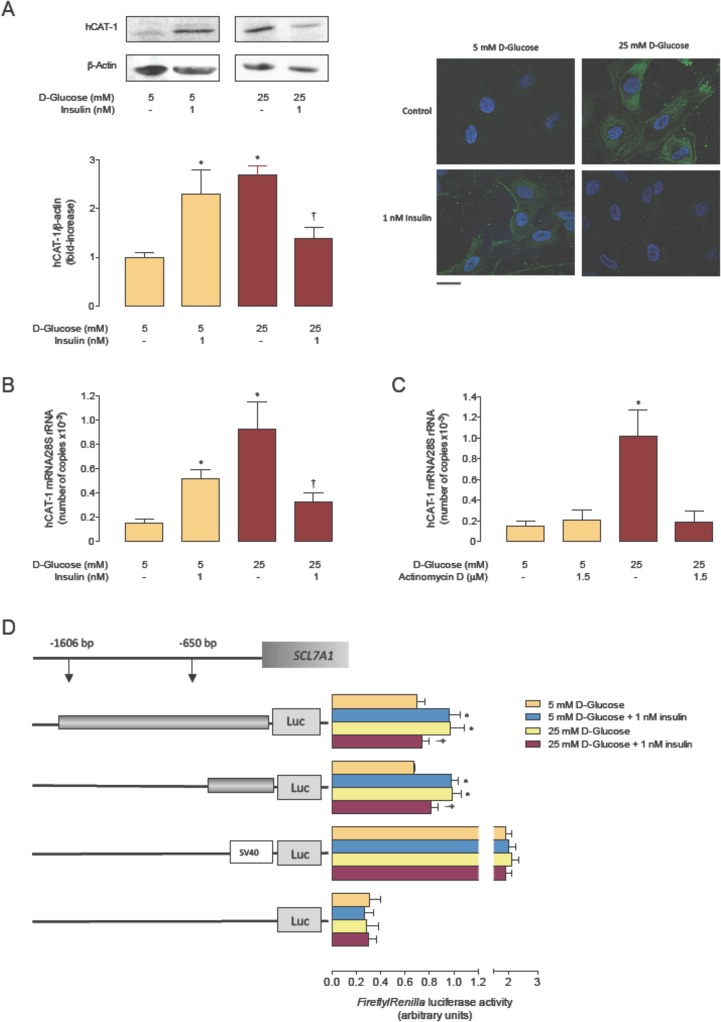
Insulin blocks high D-glucose-increase in hCAT-1 expression.A, Western blot for hCAT-1 protein abundance in whole HUVECs extracts incubated (24 hours) in 5 or 25 mmol/L D-glucose in the absence (–) or presence of insulin. Lower panel: hCAT-1/β-actin ratio densitometries normalized to 1 in 5 mmol/L D-glucose in the absence of insulin. β -Actin is internal reference. B, Immunocytochemistry of hCAT-1 (green fluorescence) in cells as in A. Control are cells in the absence of insulin. Bar indicates 5 μm at 60x microscopy magnification. C, Number of copies of hCAT-1 mRNA and 28S rRNA (internal reference) in cells as in A. D, Number of copies of hCAT-1 mRNA and 28S rRNA in cells incubated (24 hours) with 5 or 25 mmol/L D-glucose in the absence (–) or presence of actinomycin D. E, Luciferase reporter construct containing two truncations of SLC7A1 promoter (-1606 bp (pGL3-hCAT-1-1606) and -650 bp (pGL3-hCAT-1-650) from ATG) were transfected in HUVECs primary cultures as in A. In A, C and E, *P<0.04 or †P<0.05 versus 5 mmol/L D-glucose in the absence of insulin. In C, *P<0.03 versus all other values. Values are mean ± S.E.M. (n = 5).